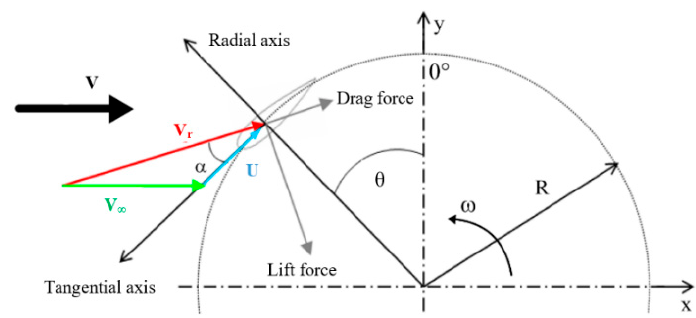
Figure 8. Forces acting on the turbine blade.